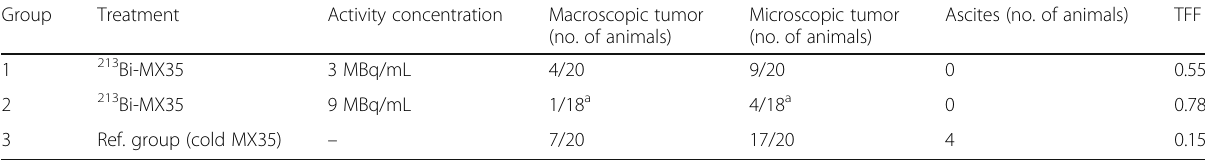
Table 1 Results after treatment with 213 Bi-MX35 and unlabeled MX35 Group